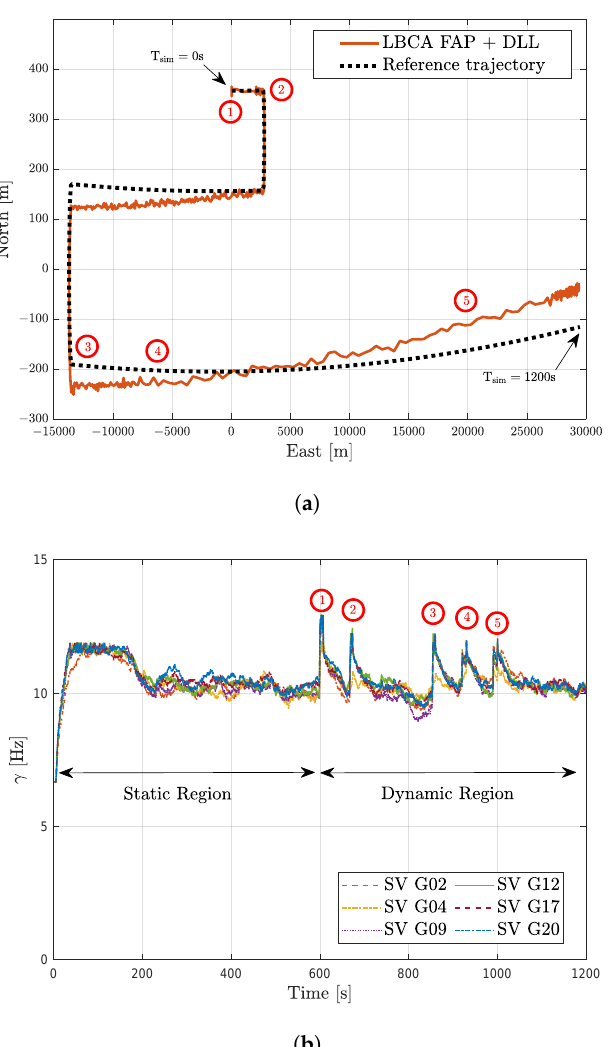
Figure 13. Results of LBCA-based FAP with unaided DLL at 34 dBHz in a dynamic scenario. ( a ) Com- parison between reference trajectory and estimated trajectory from GOOSE. ( b ) Loop-bandwidth variation of FAP